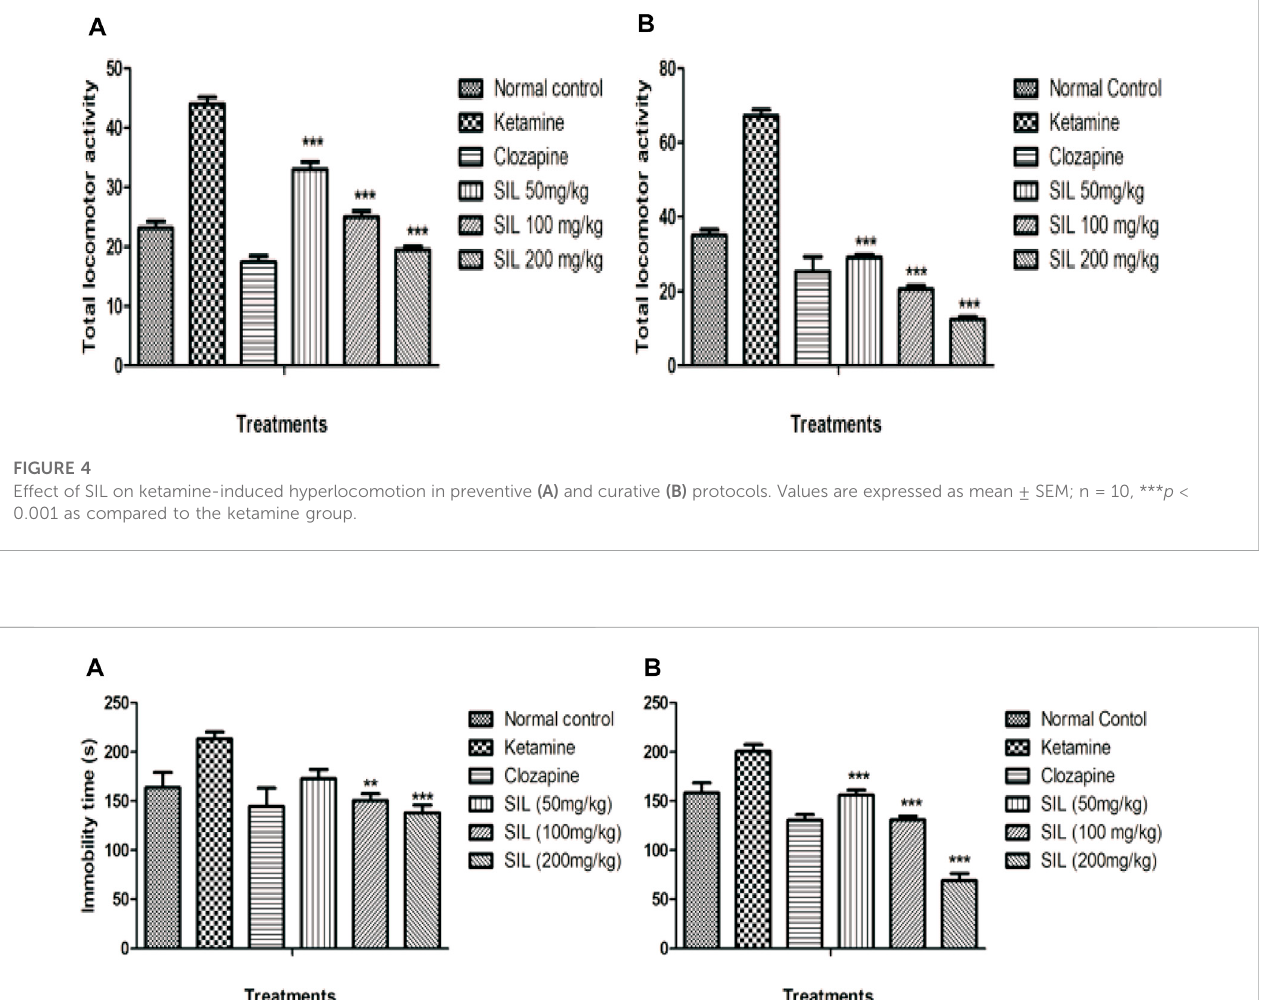
FIGURE 5 Effect of SIL on ketamine-induced immobility in forced swim test in preventive (A) and treatment (B) protocols. Values are represented here as mean ± SEM; n = 10, where ** p < 0.01, *** p < 0.001 compared to the ketamine group.